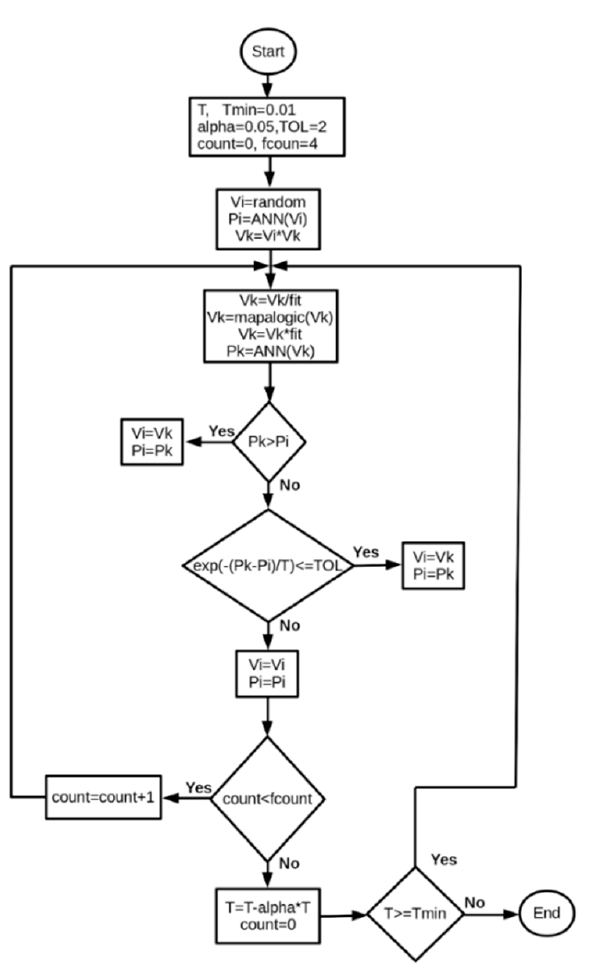
Figure 4. Flowchart of the simulated annealing algorithm.